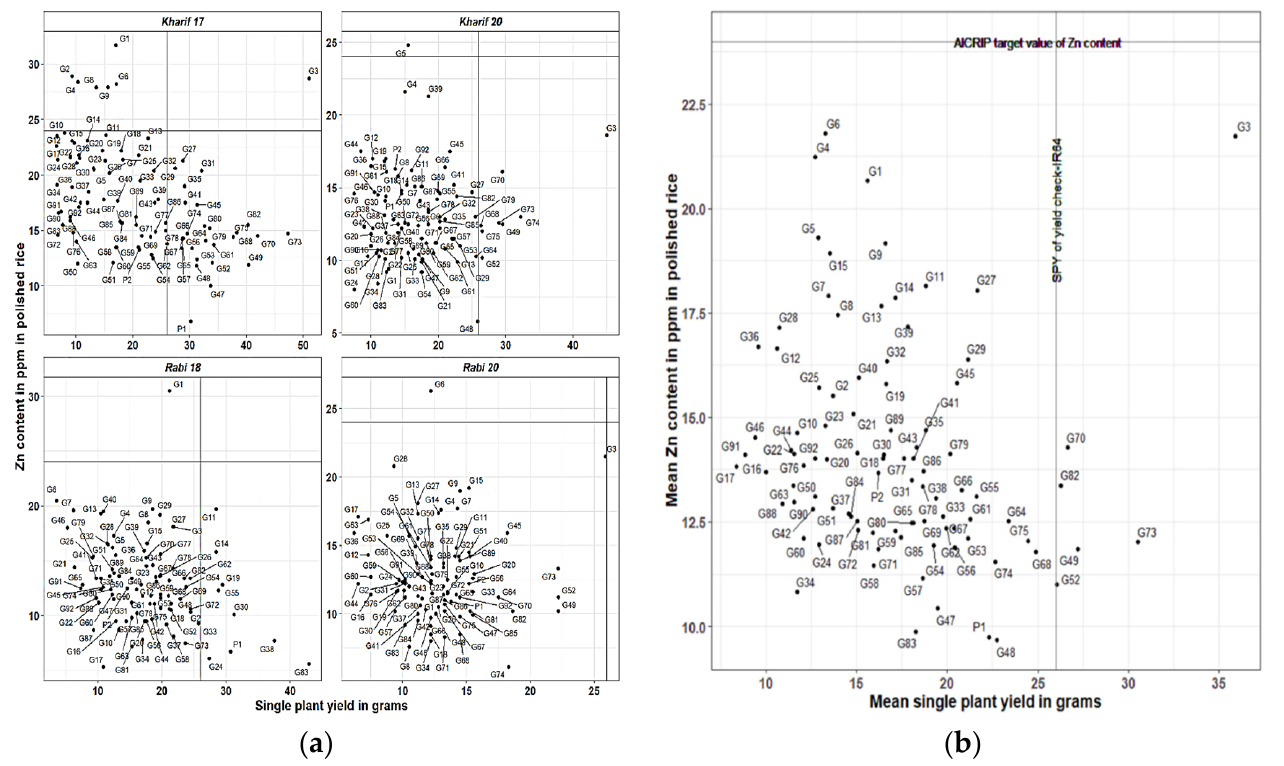
Figure 1. ( a ) Individual comparison of 92 RILs with respect to zinc (Zn) content and single plant yield (SPY) in four seasons; ( b ) mean zinc (Zn) content vs. mean single plant yield (SPY) across four seasons. Table 2. Pearson correlation analysis for agronomic, yield-, and mineral-related traits evaluated during two wet seasons (WS) and two dry seasons (DS)